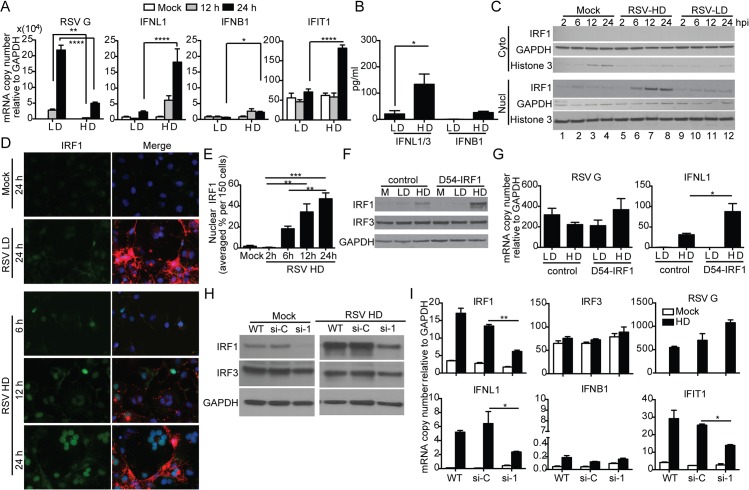
RSV iDVGs stimulate an IRF1/IFNL1-mediated antiviral response.A549 cells were infected with RSV-LD or RSV-HD at a moi of 1.5 TCID50/cell. Expression of (A) RSV G and antiviral genes mRNA, and (B) protein level of IFNB1 and IFNL1/3 in the cultures supernatants at 24 h post infection (*p<0.05 by one way unpaired t-test). (C, D) Cells were lysed or fixed at 2, 6, 12, and 24 h post infection for western blot (WB) and IFA. (C) For WB, nuclear and cytosolic fractions were immunoblotted for IRF1, GAPDH, and Histone 3. (D) For IFA, cells were co-stained for IRF1 (green, left panel), RSV F + G proteins (red in merged panel), and nuclei (blue). (E) Quantification of nuclear IRF1 upon iDVGs stimulation at designated time points post RSV-HD infection based on IFA images. (F, G) D54 control cells and D54 cells overexpressing IRF1 (D54-IRF1) were infected with RSV-HD at a moi of 1.5 TCID50/cell for 6 h. (F) IRF1 and IRF3 protein detected by WB from whole cell lysates. (G) Expression of RSV G and IFNL1 mRNA. (H, I) A549 cells were mock transfected (WT) or transfected with control siRNA (si-C), or IRF1 siRNA (si-1). After 40 h, the cells were mock infected or infected with RSV-HD at moi of 1.5 TCID50/cell. (H) WB for IRF3 and IRF1 was performed to confirm specific knockdown of IRF1 protein. (I) Expression of RSV G and other antiviral genes at 10 h post infection. Gene expression is shown as copy number relative to a house keeping gene expression index determined from the expression of ACTB (β-actin) and GAPDH. All error bars indicate mean ± SEM of at least three independent experiments (*p<0.05, **p<0.01, ***p<0.001, ****p<0.0001 by two-way ANOVA with Bonferroni post hoc test).